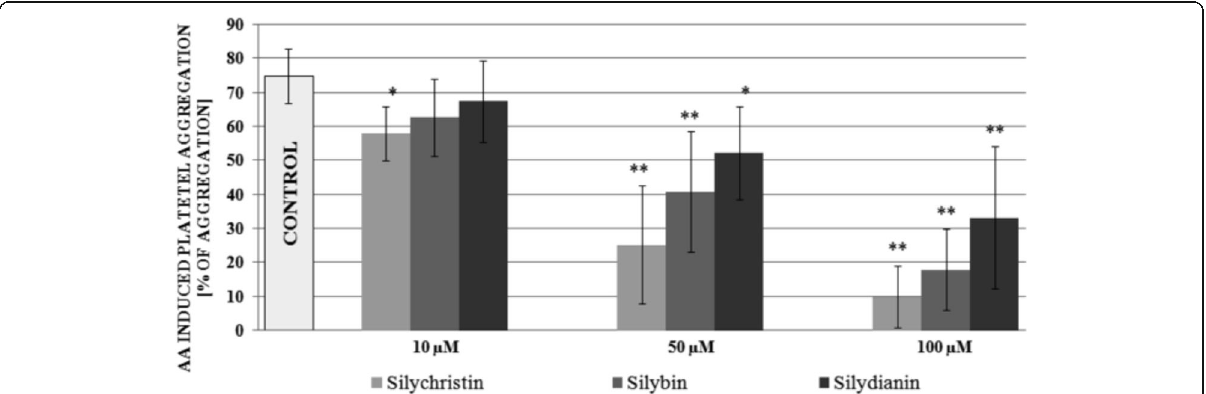
Fig. 1 The effect of flavonolignans (silychristin, silybin and silydianin in concentrations of 10; 50 and 100 μ M) on blood platelet aggregation induced by arachidonic acid in platelet-rich plasma. The data represents means of ± SD, n = 12. Statistical analysis was performed using Tukey ’ s Range Test, * p < 0.05, ** p <